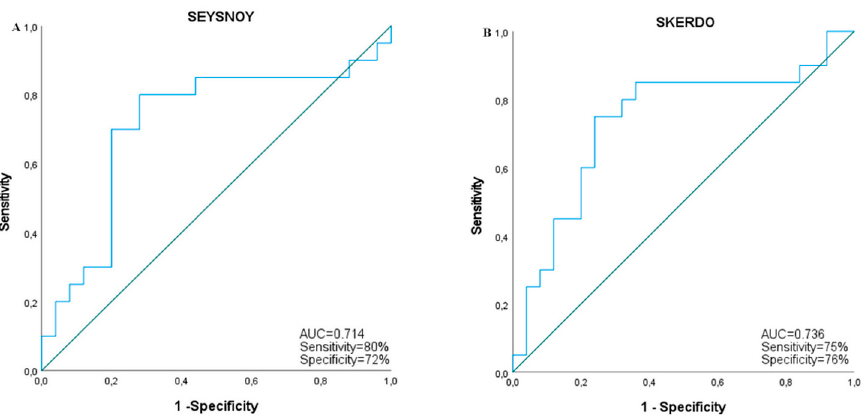
Figure 6. Receiver Operating Characteristic (ROC) analysis for predicting seysnoy ( A ) and skerdo ( B ) as biomarkers of kidney function impairment in DKD (eGFR stage G3 versus G2). Table 4. p -values and fold-change expression values of selected transcripts analyzed through Real- Time PCR in the validation cohort in G3 versus G2 or G1 comparisons.